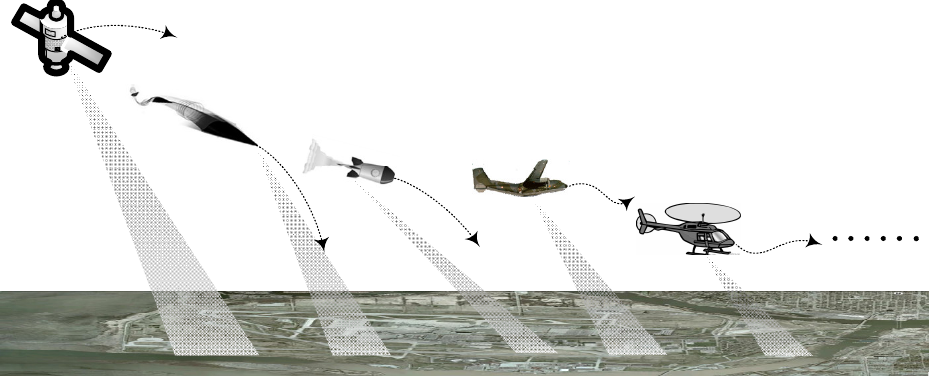
Figure 1. Schematic diagram of commonly used CF-SAR payload platforms.